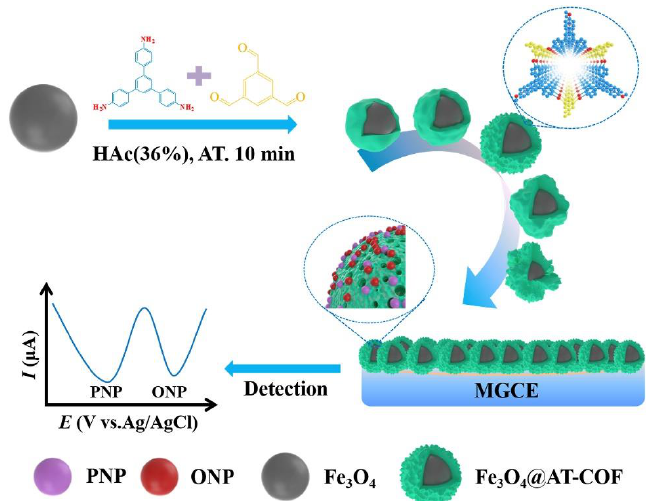
Figure 2. Schematic illustration of a glassy carbon electrode modified with a magnetic Fe 3 O 4 @AT- COF nanocomposite used for the simultaneous detection of PNP and ONP . Reprinted with permis- sion from Ref. [85]. Copyright 2019